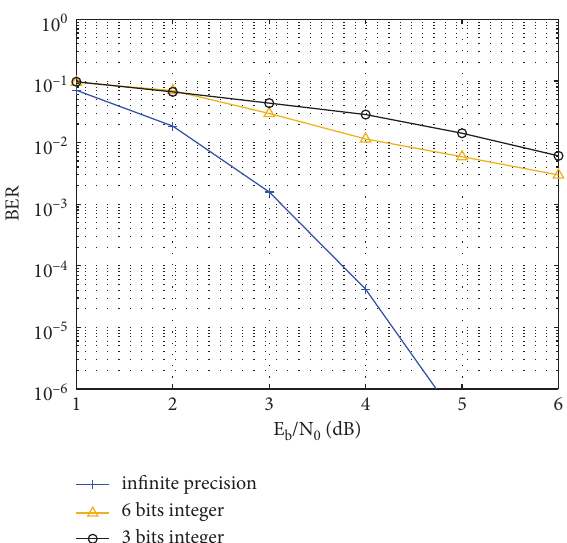
Figure 8: Efect of integer quantization on SPA decoding. Te block length and code rate of LDPC code are n � 264 bits and R � 2/3,